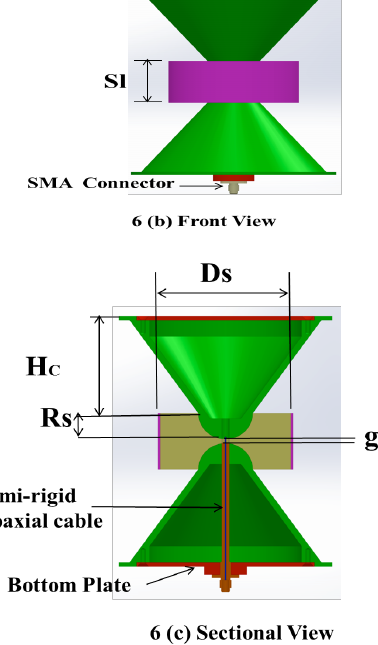
Figure 6: Canonical Sleeve Antenna (CSA) 6(a) Isometric view, 6(b) Front view, 6(c) Sectional view